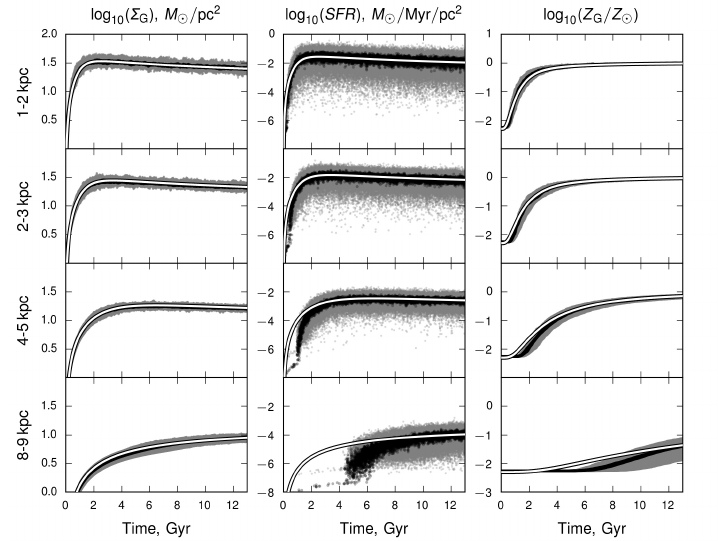
Fig. 3. The evolution of the gas surface density, SF surface density and gas metallicity in radial rings. The white line indicates a smooth SF in 1-D galaxy model based on the stochastic 2-D model (LS). The black dots represent eight independent runs of the LS model averaged within 1 kpc wide rings, the gray dots are for 0.1 kpc wide rings. The time step of the LS models is 10 Myr.